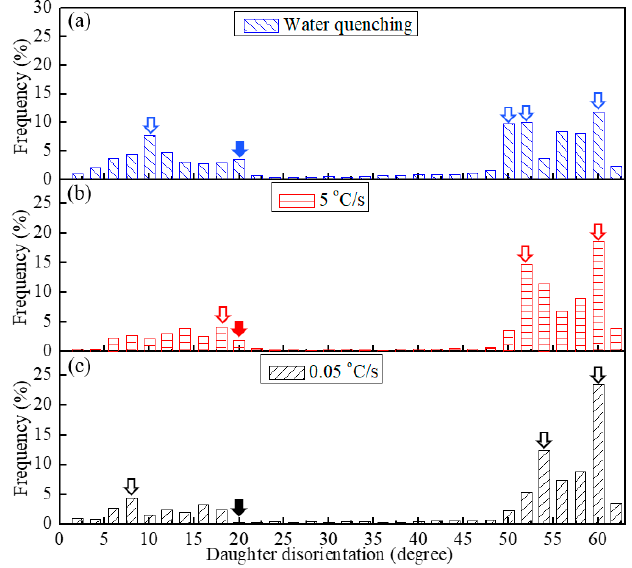
Figure 6. Histogram of daughter grain disorientation in three specimens at various cooling rates: ( a ) water-quenching; ( b ) 5 °C/s; ( c ) 0.05 °C/s.